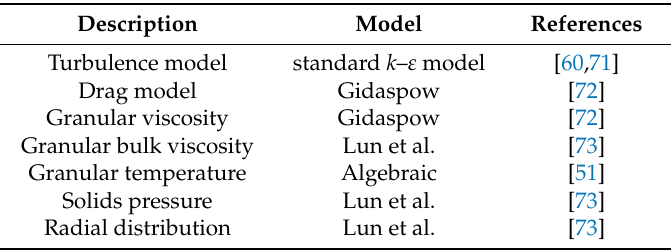
Table 3. Closure models used in